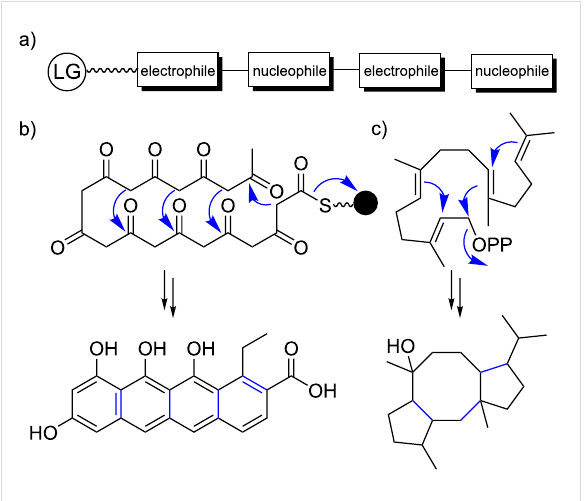
Figure 2: Repetitive electrophilic and nucleophilic functionalities in terpene and type II PKS-derived polyketide biosynthesis. a) Schematic representation. b) Type II PKS-derived polyketide biosynthesis. c) Terpene biosynthesis. LG: leaving group, black ball: acyl carrier pro-